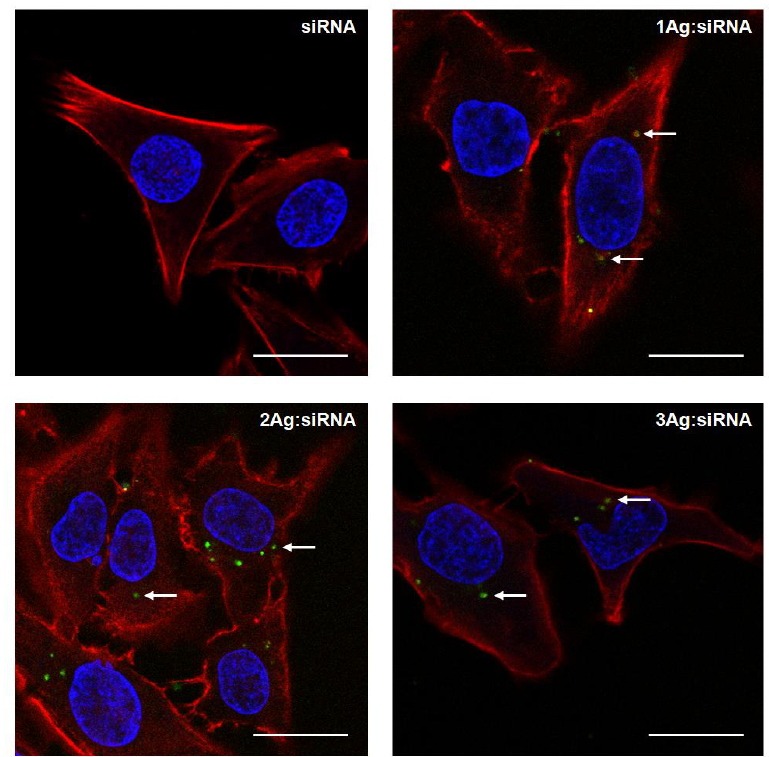
Figure 7. Confocal microscopy images of HeLa cells after 24 h of incubation with free FITC-labeled siRNA (siBcl-xl, 100 nM) or its complexes with 1Ag, 2Ag, and 3Ag prepared in dendron:siRNA molar ratios of 55:1, 12.5:1, and 7.5:1, respectively. Bar = 10 μm. White arrows indicate FITC-labeled siRNA inside the cells.